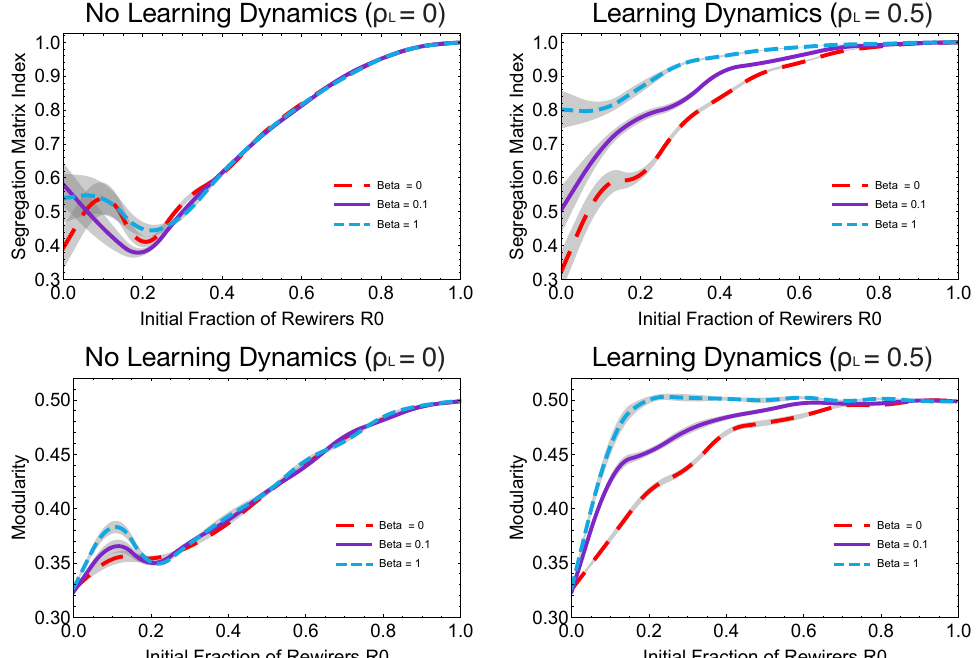
Figure 4. Segregation results for different hidden layers and R -agents. Segregation matrix indexes (SMI) ( top row ) and modularity ( bottom row ) for different values of initial fractions of R -agents ( R 0 ), hidden layer topologies ( β ) and either for no learning in the system ( left panels ) or learning rate ρ L = 0.5 ( right panels ). Every data point is averaged over 50 different replicates. Error bars are represented as gray overlays. When no learning is present in the system, consensus is reduced across all topologies when an optimal number R ∗ of R -agents is initially present in the system. Hence, there is an optimal number 0 of R 0 for reducing segregation. Above that value, the more R -agents in the system the more segregation is present and all curves converge on the same trajectory. The presence of learning destroys this overall convergence so that different hidden topologies display different levels of